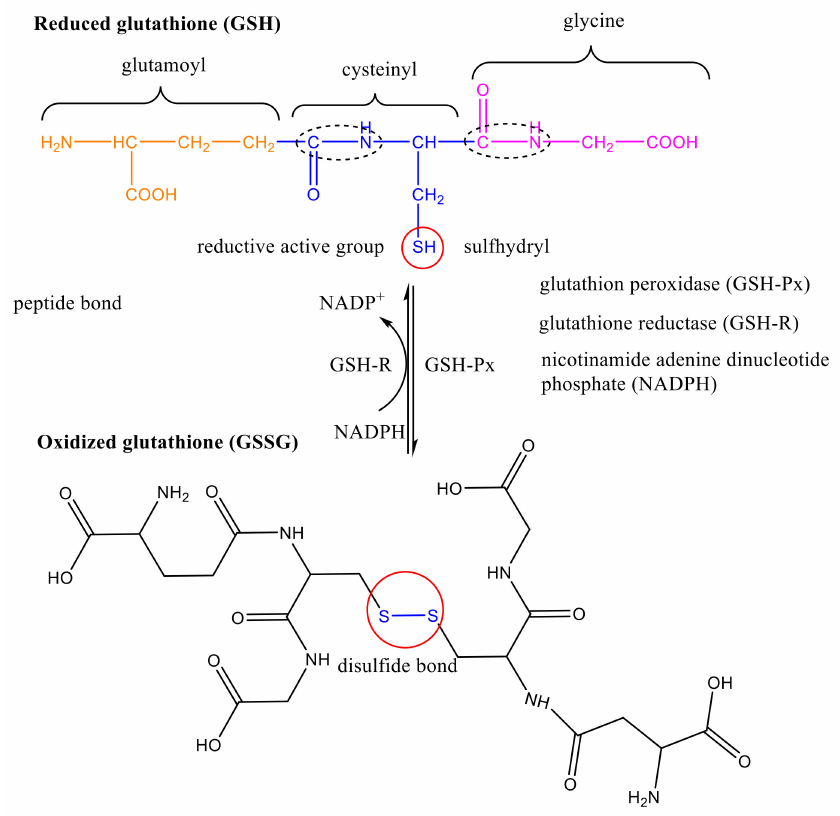
Figure 1. Structure and synthesis procedure of GSH and